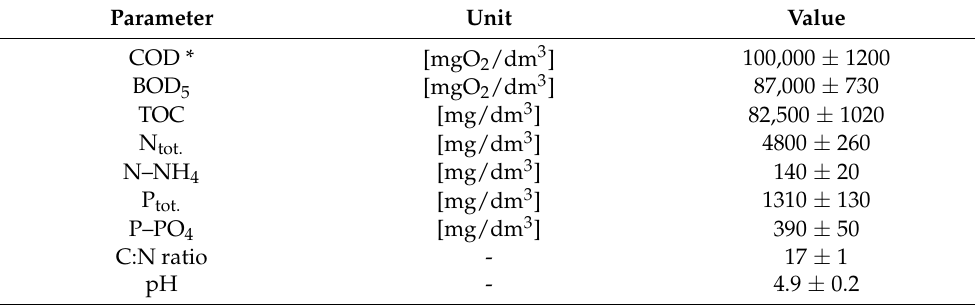
Table 2. Characteristics of acid whey solution used in